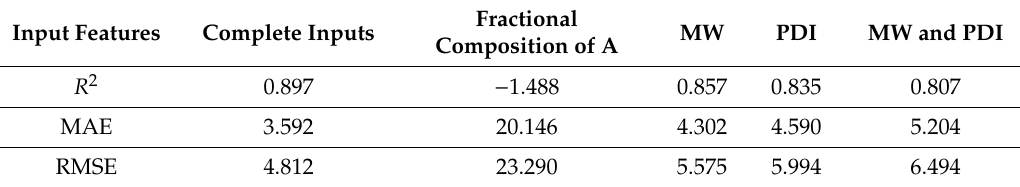
Table 6. The R 2 , MAE, and RMSE with DNN model prediction when di ff erent input variables are estimated with their minimum values.